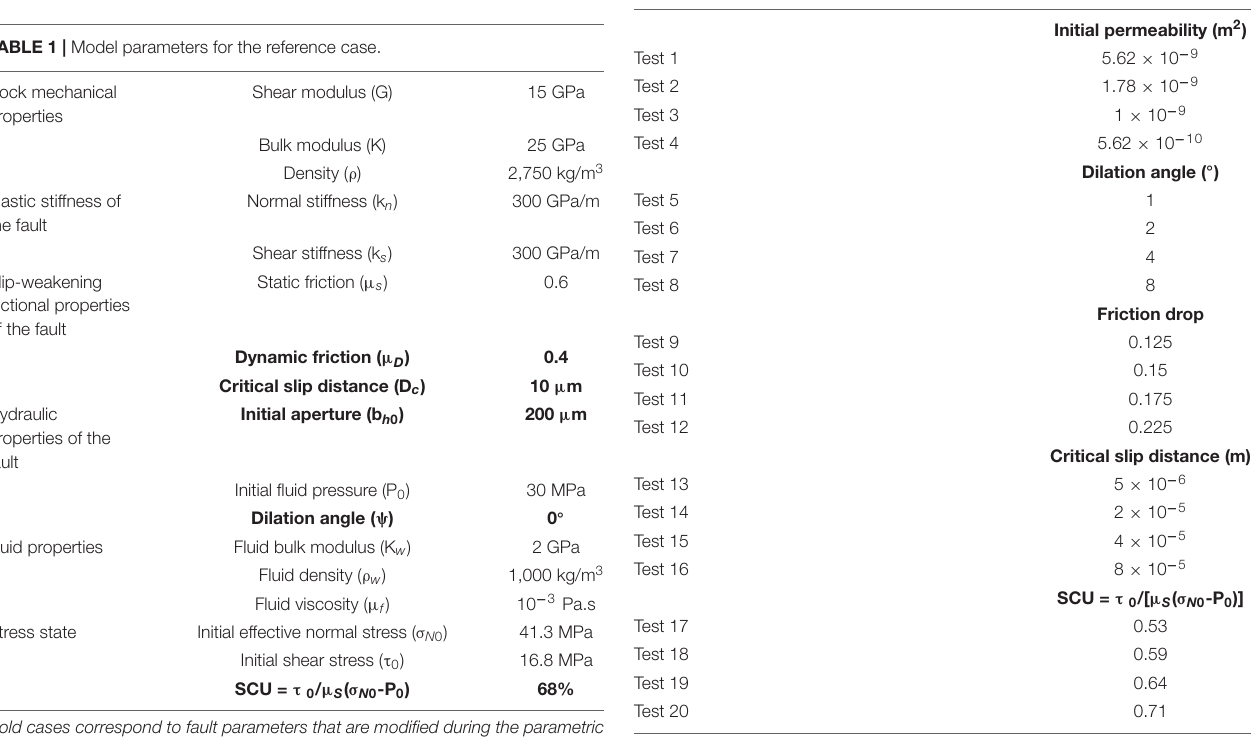
TABLE 2 | Varying fault parameters (initial permeability, dilation angle, friction drop, critical slip distance, SCU) for the reference case and the other 20 simulations considered in this